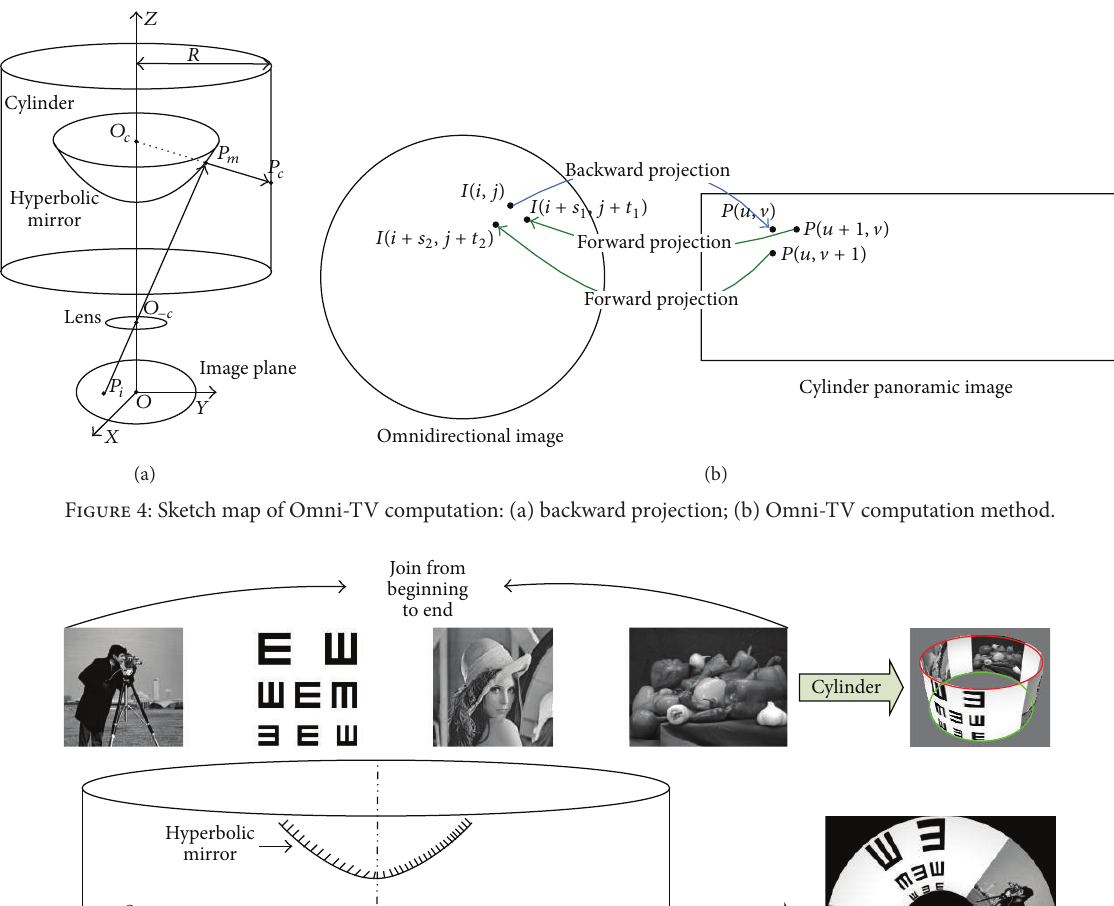
Figure 3: Catadioptric camera and omnidirectional image.